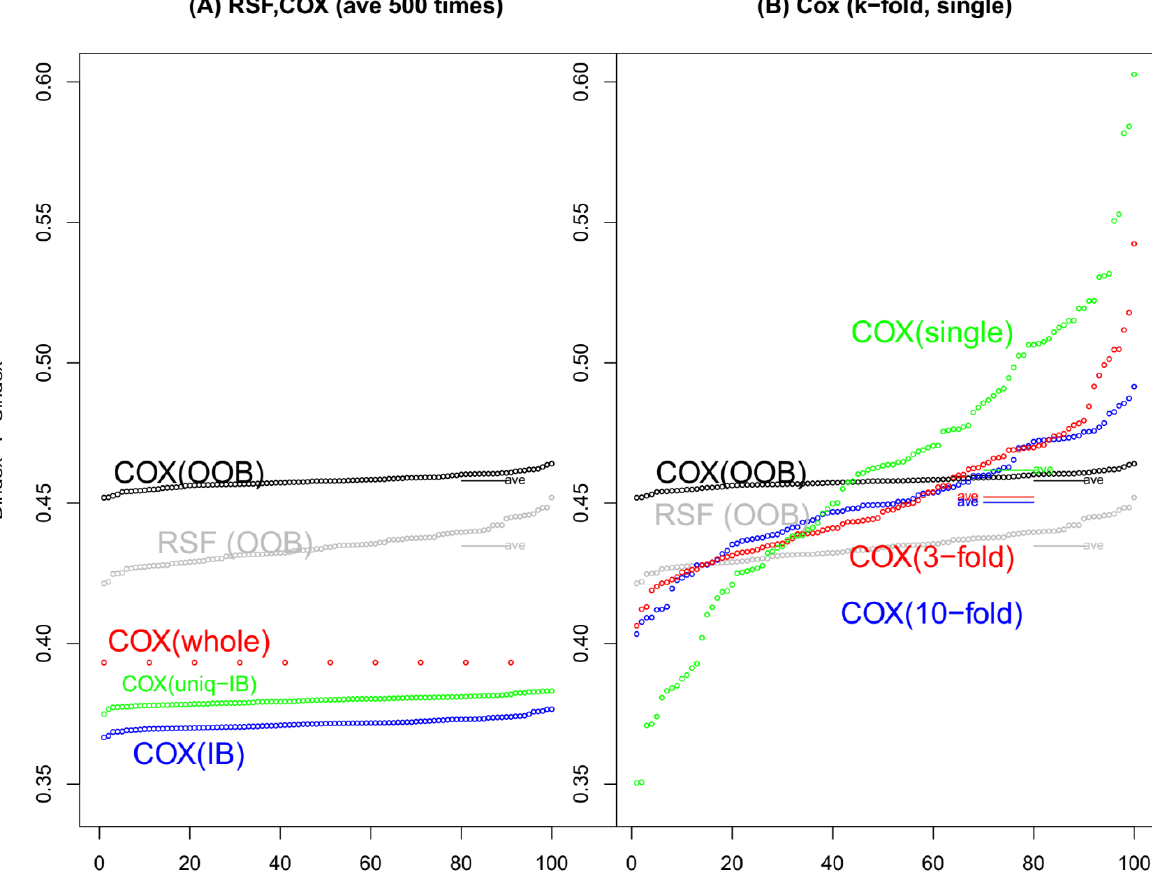
Figure 3. D-index (discordance index, or 1-Cindex, or C-error) by both Random Survival Forest (RSF) and Cox regression for the colorectal survival dataset in various validation set selections and choice between ensemble or single classifier. (A) RSF-OOB (grey), Cox-OOB (black), Cox-IB (blue), Cox-unique-IB (green), Cox-whole (red). The mean of RSF-OOB (grey) and mean of Cox-OOB (black) are shown by two short horizontal bars; (B) Cox-10-fold-CV (blue), Cox-3-fold-CV (red), Cox-OOB-single-classifier (green). The RSF-OOB, Cox-OOB are reproduced in (B) as a comparison. The means of Cox-10- fold-CV (blue), Cox-3-fold-CV (red), and Cox-OOB-single-classifier (green) are shown by short horizontal